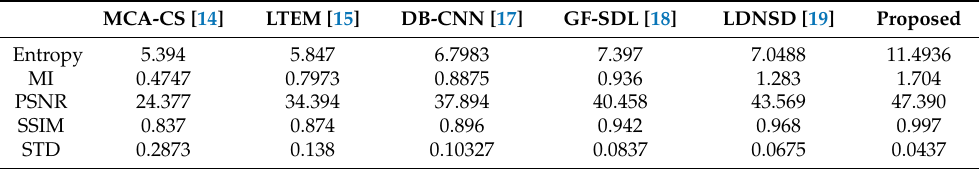
Table 6. MR-CT image fusion approaches performance analysis.